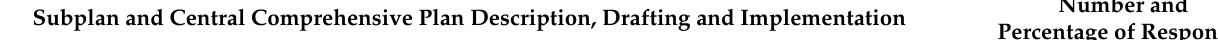
Table 3. Survey responses from 14 cities about their network of plans